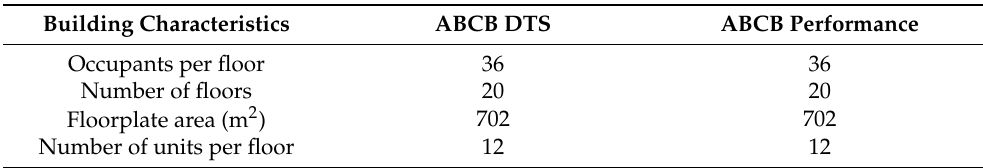
Figure 2. Two solutions for Case #1 Australian Building Codes Board (ABCB) model residential building. Table 1. Characteristics of Case #1- Australian Building Codes Board (ABCB) Deemed-to-Satisfy (DTS) and Performance